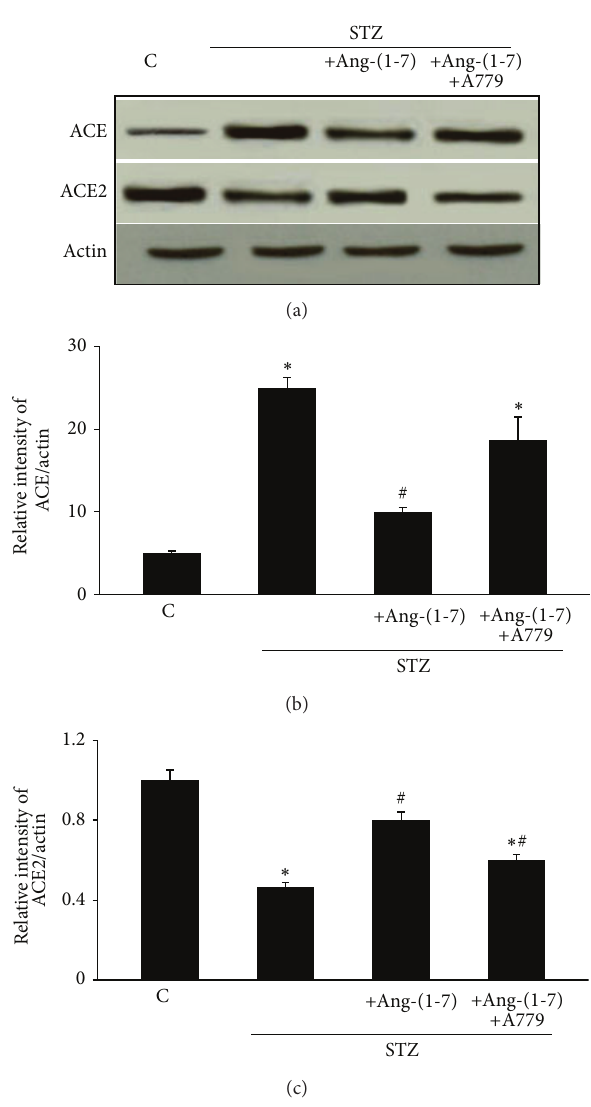
Figure 4: The levels of ACE and ACE2 protein expression in corpus cavernosum of nondiabetic (C), diabetic (STZ), and STZ-rats chronically treated either with Ang-(1-7) alone (STZ + Ang-(1-7)) or in combination with A779 (STZ + Ang-(1-7) + A779). Panel (a) is a representative western blot showing the levels of ACE, ACE2, and the protein loading control, 𝛽 -actin. Panels (b) and (c) are densitometry histograms showing levels of ACE and ACE2 normalized to actin, respectively. 𝑁 = 4 ; Mean ± SD. Asterisk ( ∗ ) indicates significantly different ( 𝑃 < 0.05 ) mean values from normal nondiabetic rats (C), whereas hash (#) indicates significantly different mean values ( 𝑃 < 0.05 ) from diabetic rats